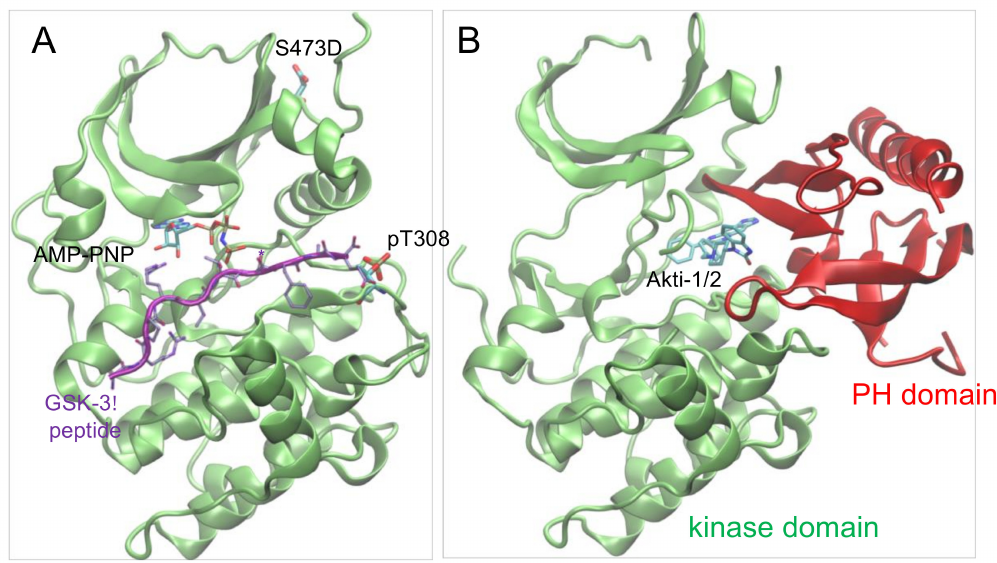
Figure 6. Structure of Akt1 in active and inhibitor bound forms. ( A ) Structure of ∆ PH-pAkt1 Thr308 Ser473Asp (PDB 1O6K [35]) is shown in complex with ATP analog (ANP-PNP) and substrate peptide (purple). ( B ) Structure of the full-length Akt1 (unphosphorylated) is shown in complex with the Akti-1/2 inhibitor VIII (PDB 1O96 [36]) binding in the cleft between the kinase domain (green) and the N-terminal PH domain